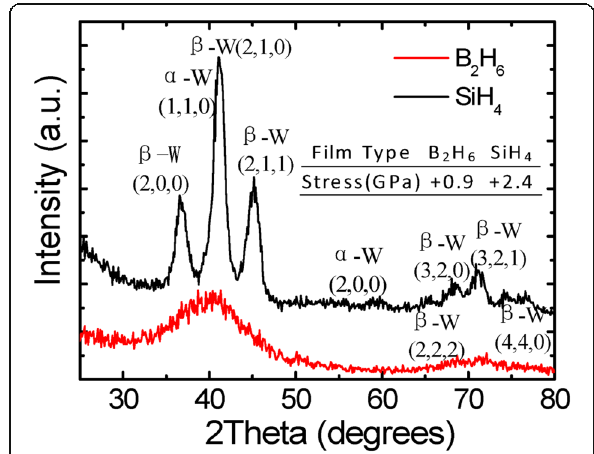
Fig. 2 XRD spectra of ALD W using SiH 4 and B 2 H 6 and calculated stress data on blank